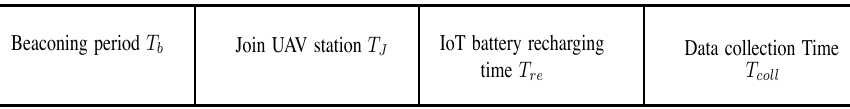
Fig. 2: Structure of coverage time Figure 2. The frame